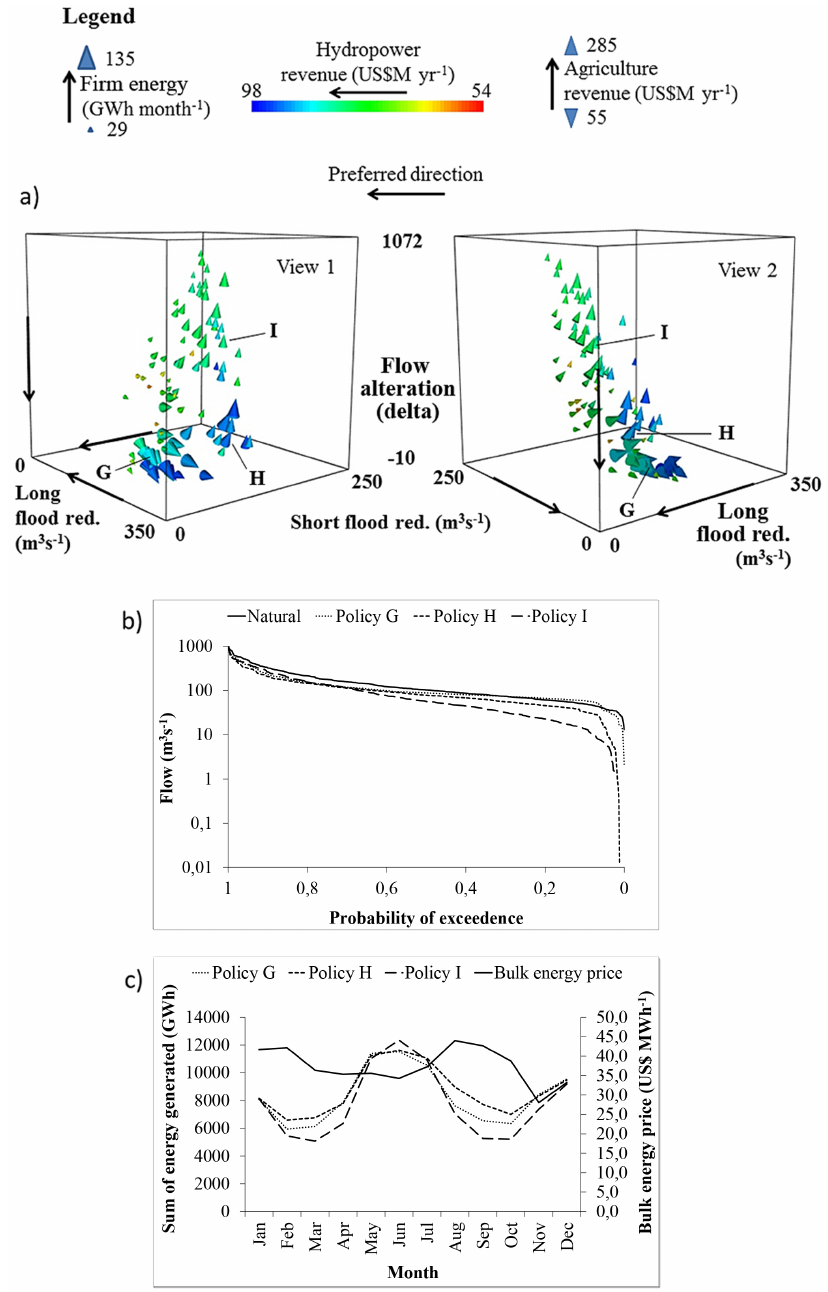
Figure 9. (a) The same trade-off surface as Fig. 7 but restricted to policies which result in no municipal deficits considering historical data. Such “brushing” of trade-off plots allows stakeholders to focus on system designs that interest them. Three policies are selected for discussion. A 3-D animation of this plot is available in online supplementary material. (b) Comparison of the flow duration curves for the three selected operating policies in (a) showing implications of the flow alteration values in Table 1. The Policy G flow regime is closest to natural conditions at both low and mid-range flows, but high flows are sacrificed to increase firm energy. Policies H and I result in the river not reaching the ocean for 1–2% of the time. (c) Plot of the total energy generation for each of three selected policies from (a) alongside the monthly bulk energy price. Higher hydropower revenue (Policy H) is achieved by generating high levels of power in months (August–October) when the bulk energy price is